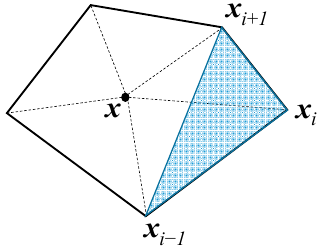
Figure 3. Triangles involved in the calculation of N i using Wachspress interpolation.